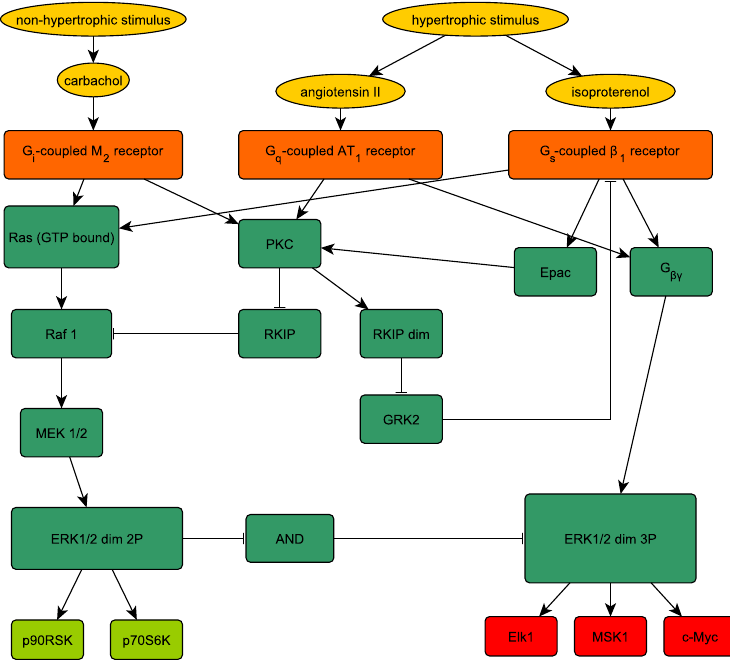
Figure 2. The graph of a network associated with a cardiomyocyte. The Network topology is shown (as in [14] (Figure 1), which includes also references and explanations for all involved nodes and their interactions; colors are different): In orange, the non-hypertrophic stimulus (left, carbachol) or the hypertrophic stimulus (either angiotensin II or isoproterenol) are active after a suitable stimulus (e.g., stress, oxygen debt of the heart, hormonal input). In green, the network of activations (arrows) and inhibitions (blunted arrows) is shown. The output is positive strengthening of the heart (left, light green), or the pathological hypertrophy of the heart (right, red boxes), the increase in the cardiac hypertrophy is mediated by the activation of transcription factors entering the nuclei of the cardiomyocytes, three important ones are